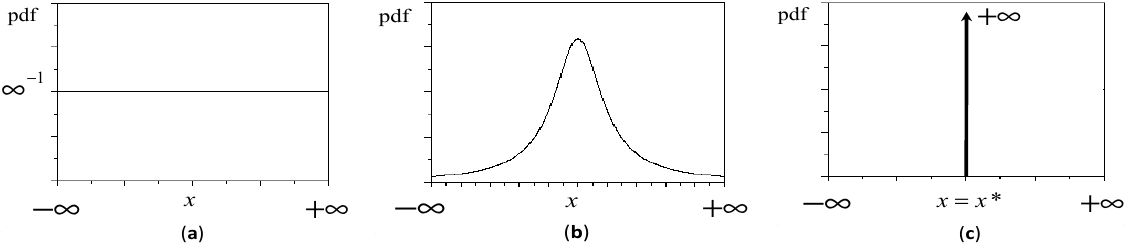
Figure 5. The mathematical representation of knowledge: ( a ) perfect ignorance; ( b ) incomplete knowledge; ( c ) perfect knowledge.